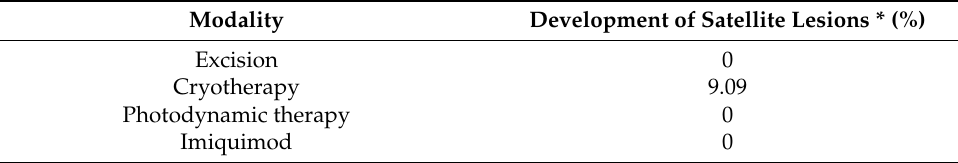
Table 2. Development of satellite